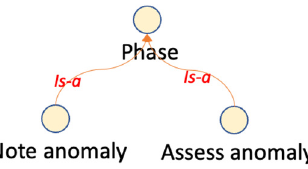
Figure 4. Class hierarchy extracted from a previous ontology in (Schmill et al. 2007). Figure elaborated by the authors.